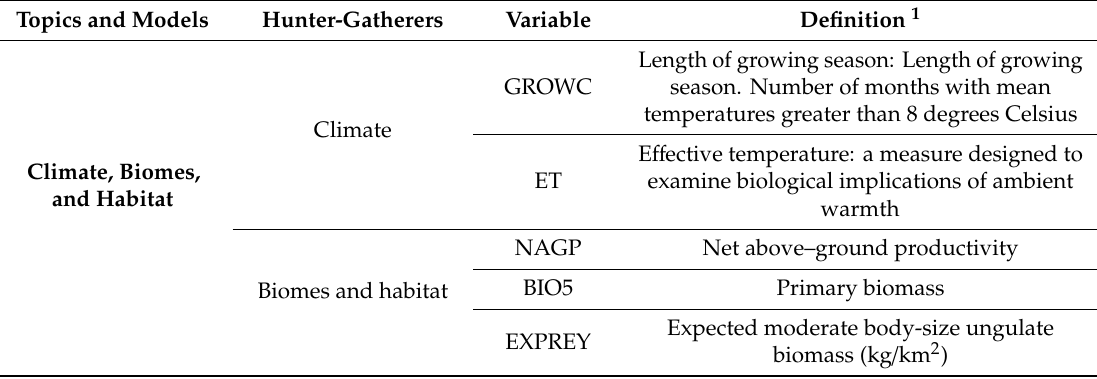
Table 1. Key variables used in this research